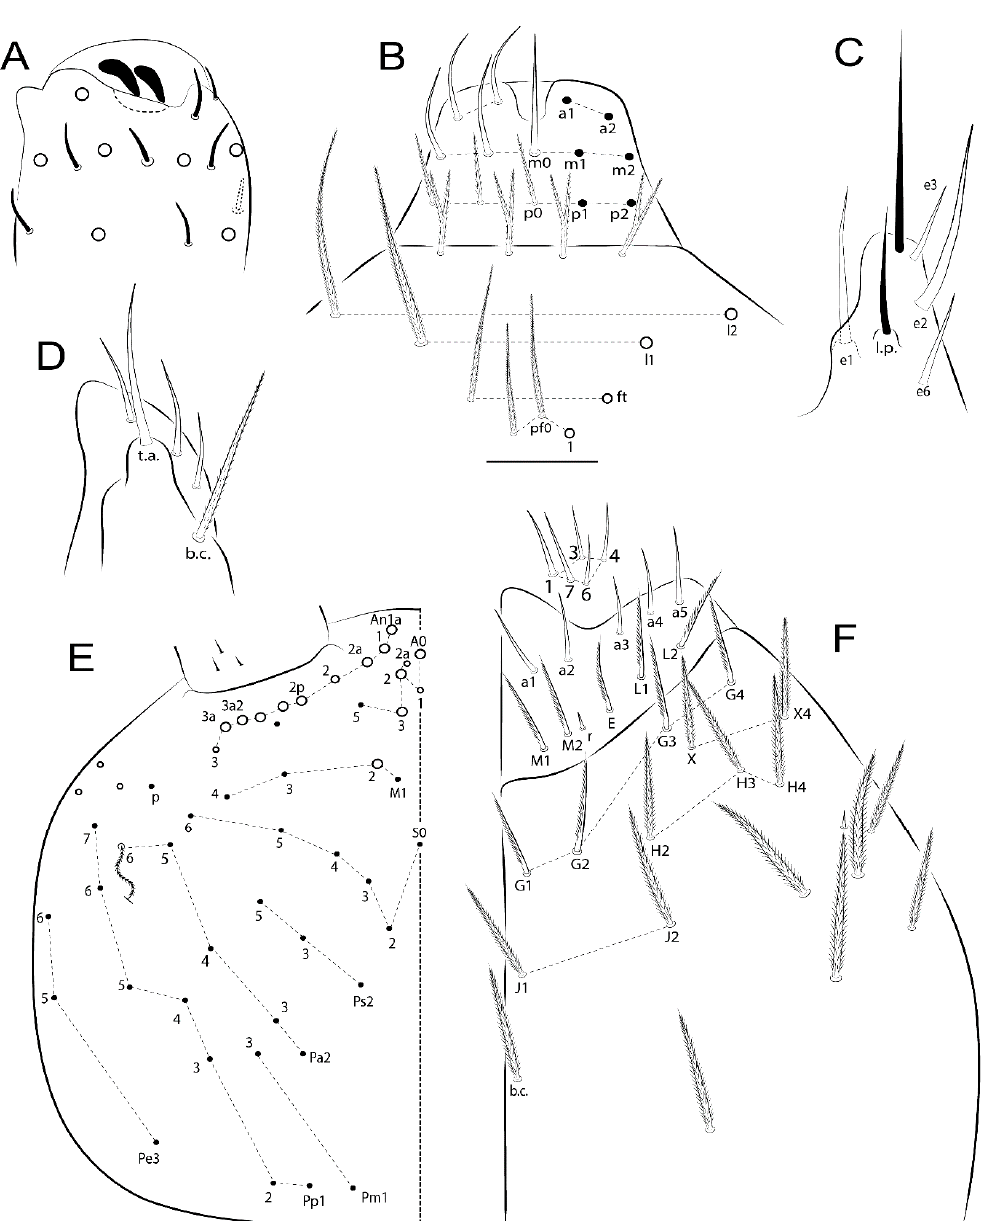
Figure 69. Pseudosinella macrolignicephala sp. nov.: head. ( A ) Ant III apical organ (lateral view); ( B ) chaetotaxy of clypeus, prelabrum, and labrum; ( C ) labial papilla E (right side); ( D ) maxillary palp and sublobal plate (right side); ( E ) head dorsal chaetotaxy (left side); ( F ) labial proximal chaetae, basomedian and basolateral labial fields, and complete postlabial chaetotaxy (right side).